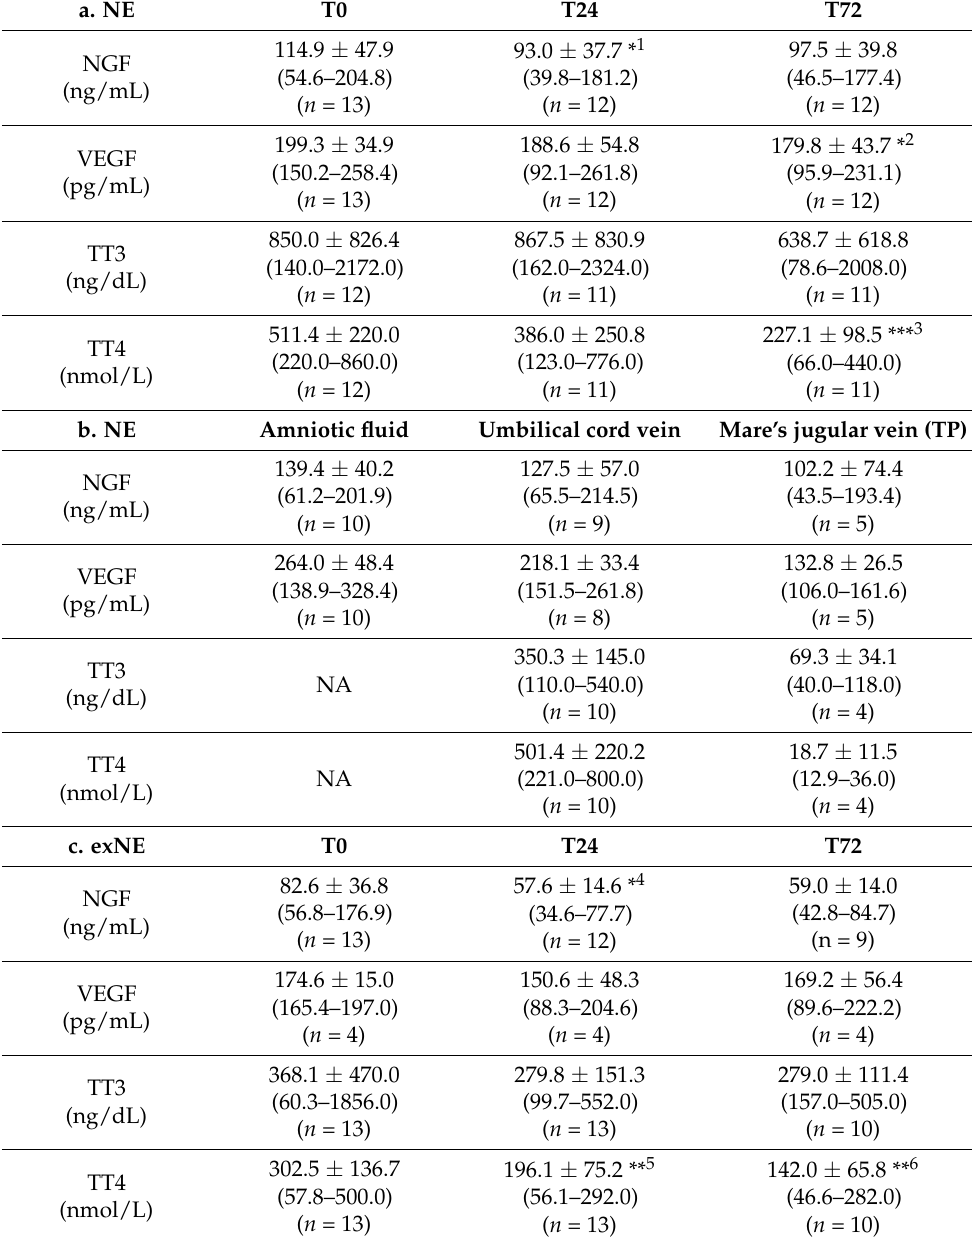
Biomarker levels in: a ; group NE—samples obtained from foal’s jugular vein at three consecutive time points (T0: birth; T24: h from birth; T72: h from birth); b ; group NE— samples obtained from amniotic fluid, umbilical cord vein and mare’s jugular vein at